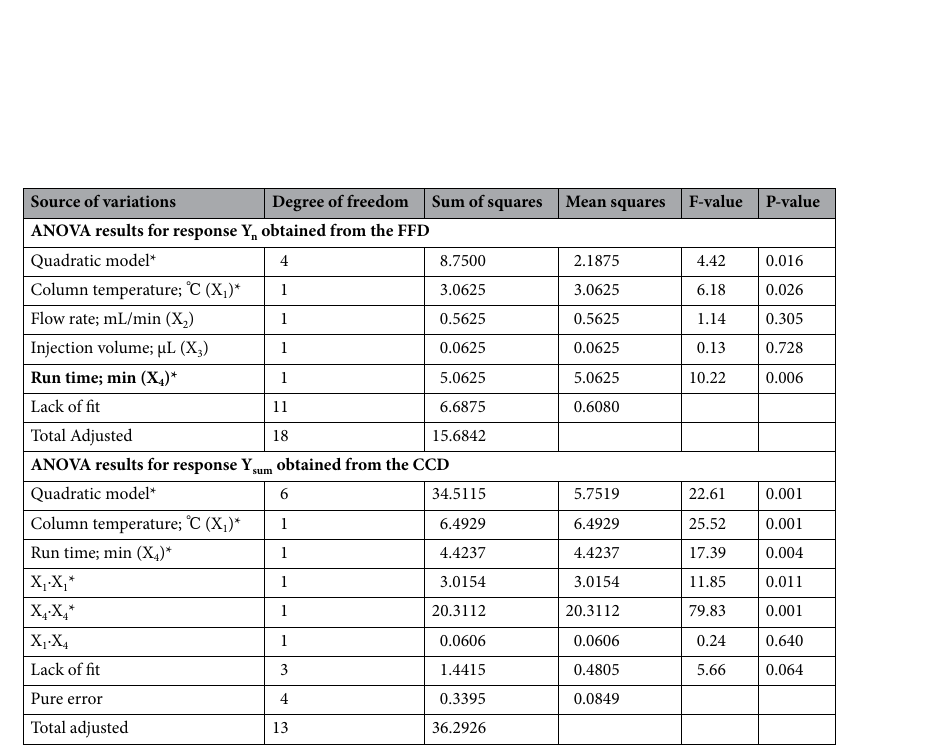
Table 4. ANOVA results for response Y n (peak numbers) obtained from the FFD factor screening and Y sum (summarizes the eleven resolutions) obtained from the CCD response surface experimental design spaces. *